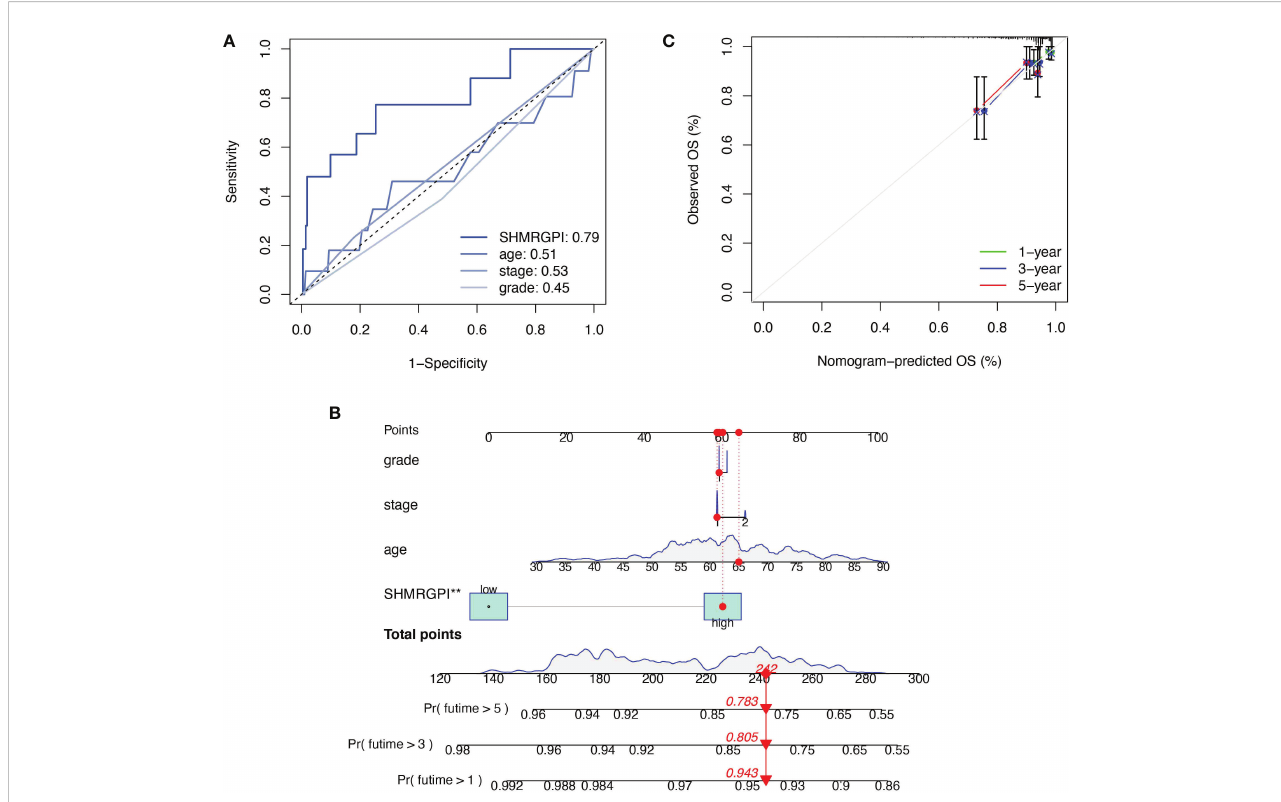
FIGURE 4 Construction and examination of nomogram. (A) The multifactor ROC of SHMRGPI, age, FIGO stage, and tumor grade. (B) The nomogram for predicting prognosis of EEC patients. **: p value < 0.01. (C) The calibration curves of the nomogram. ROC, receiver operating characteristic curve.